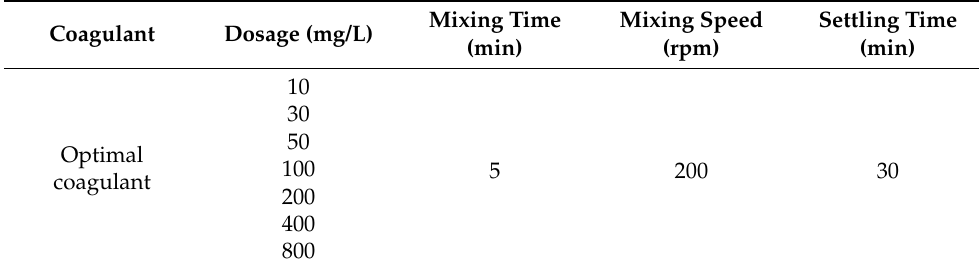
Table 2. Experimental conditions for optimal dosage